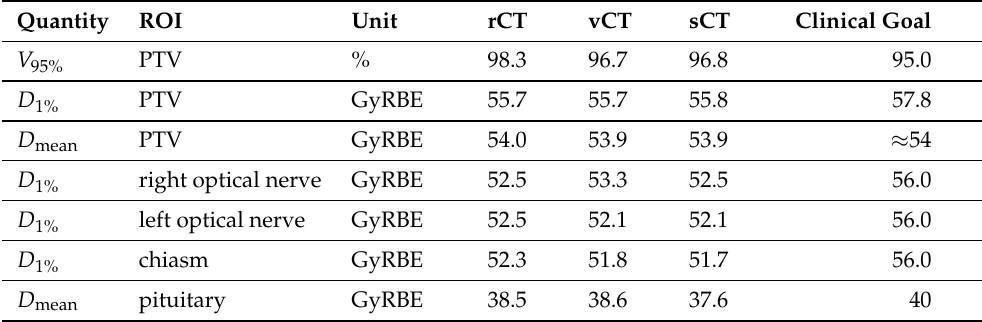
Figure 4. Clinical validation case. Left : Dose distribution of the initial treatment plan calculated and overlaid on the verification CT. Right : Dose distribution calculated an overlaid on the synthetic CT. Table 1. Clinical validation case. ‘ROI’ refers to the clinical contours. ‘rCT’ refers to the dose evalua- tion on the reference CT (planning CT), ‘vCT’ on the verification CT, and ‘sCT’ on the synthetic